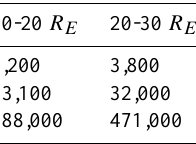
Table 1. Approximate numbers of Geotail 12-sec CPS samples for different levels of magnetospheric activity